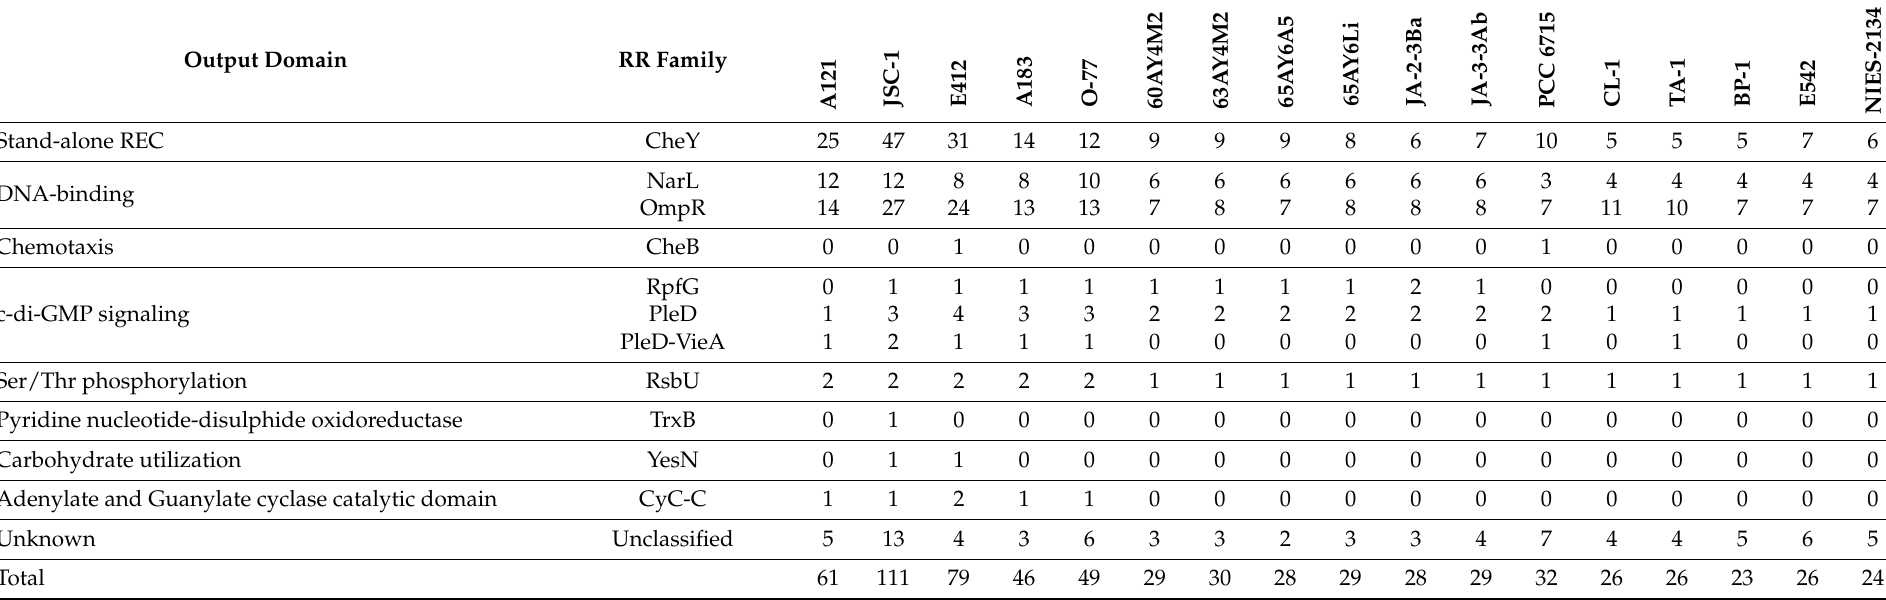
Table 5. Output domains of RRs in thermophilic cyanobacteria